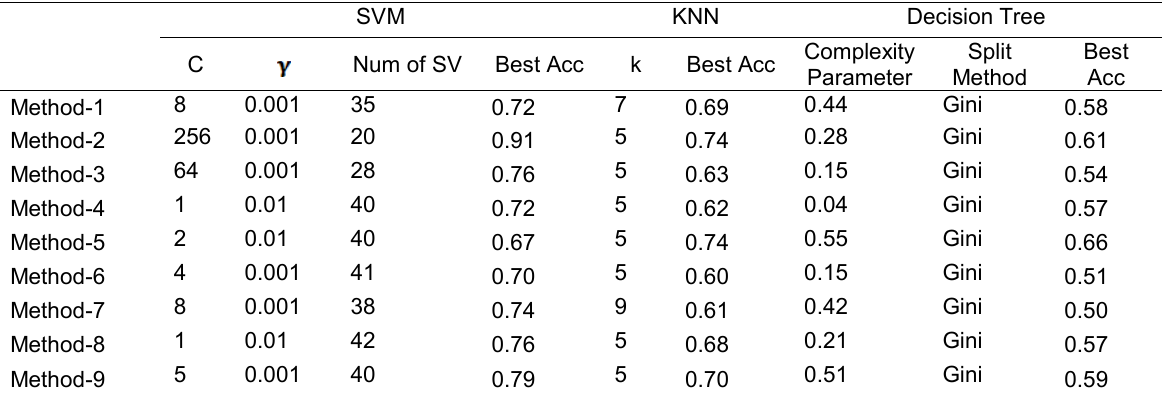
Table 6. Tuned parameters and best cross-validation accuracy of classification technique for chest